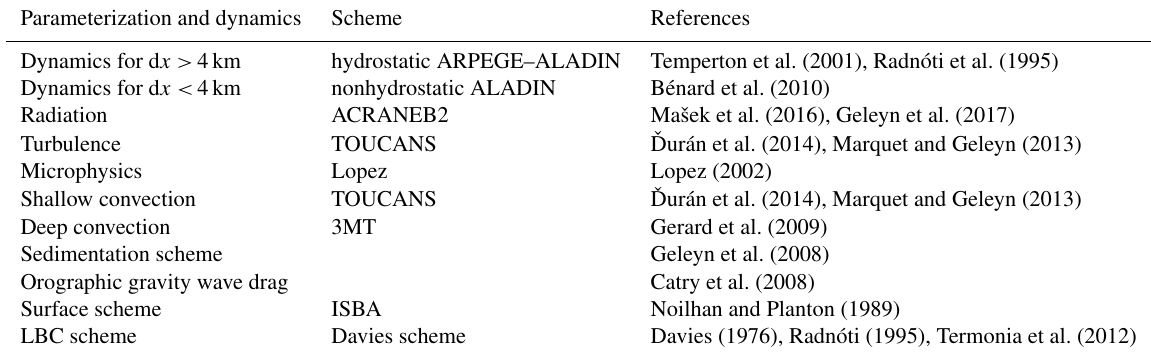
Table 4. The ALARO